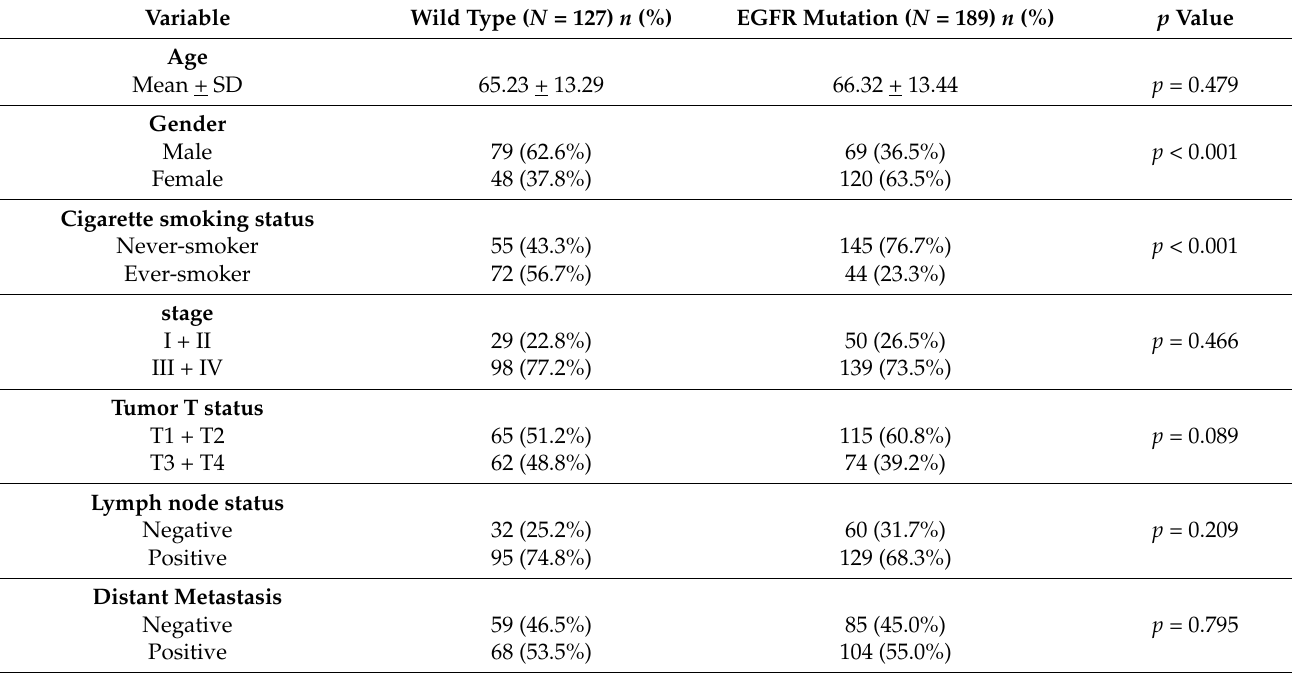
Table 1. Demographics and clinical characteristics of 316 patients in lung adenocarcinoma with EGFR mutation status.